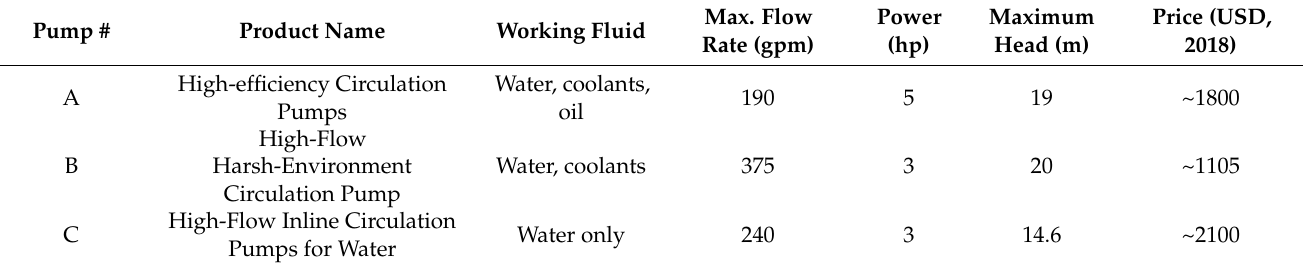
Table 3. List of potential centrifugal pumps available in McMaster–Carr and its working fluid, maximum flow rate, power requirement, maximum head, and unit price.